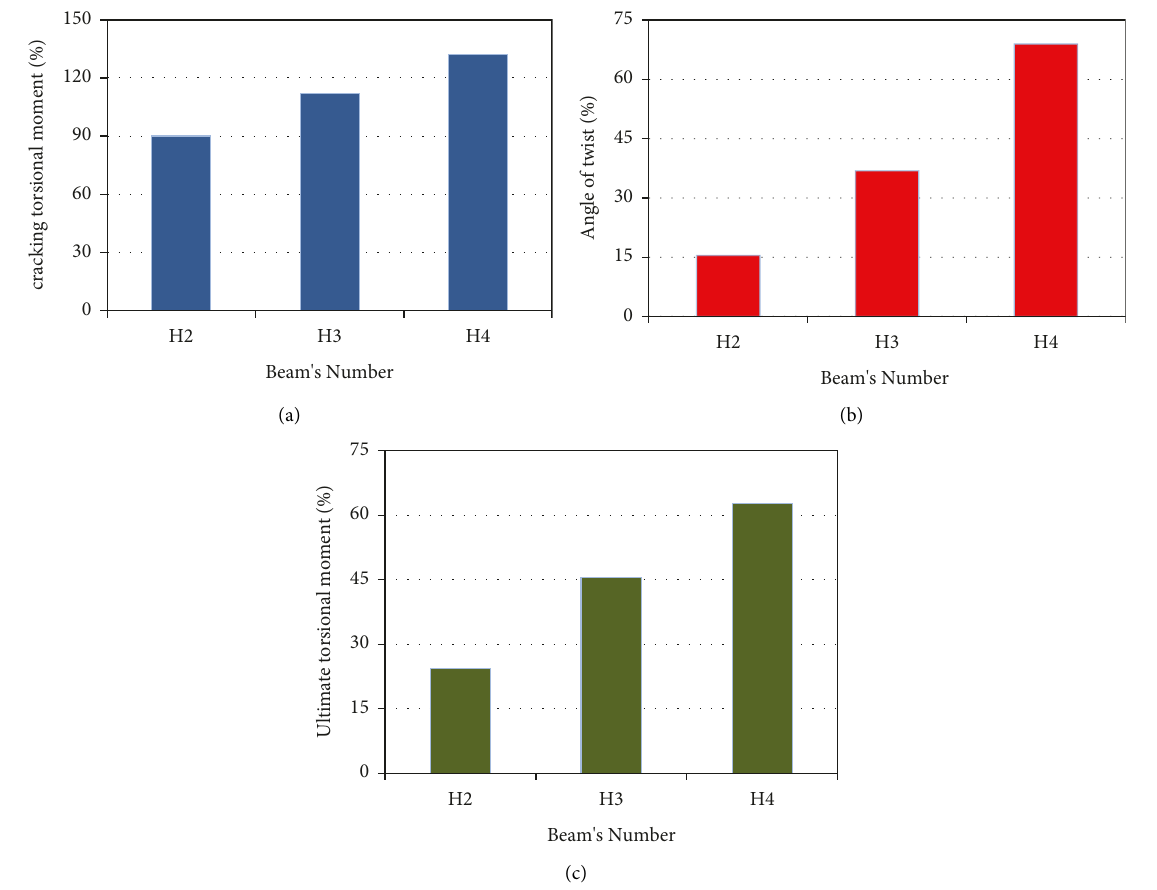
Figure 12: (a) Improvement of the Tcr. (b): Improvement of the twist angle. (c) Improvement of the Tu.